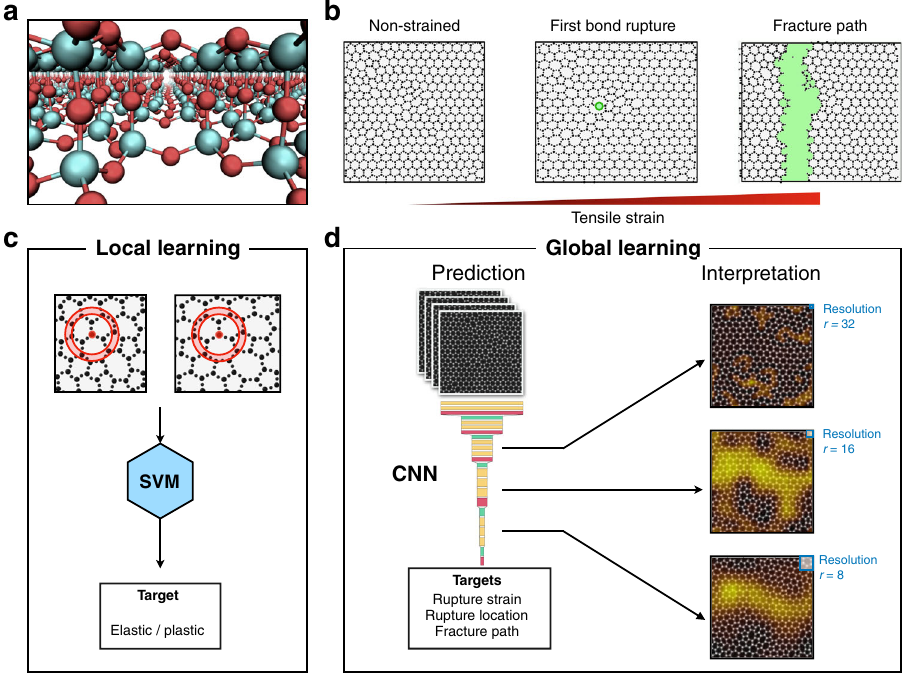
Fig. 1 Schematic of system and algorithms. a Perspective view of the silica glass bilayers: silica atoms are colored in cyan and oxygen ones in red. b Schematic representation of the fracture formation under increasing tensile strain from left to right: non-strained (left panel), fi rst plastic event corresponding to a bond breaking (central panel) and crack path (right panel). c Local learning approach that uses Support Vector Machine to predict the elastic/plastic nature of individual atoms. d Global learning approach which uses a ResNet model to predict rupture strain, location and the full crack path. The approach also allows for the interpretation of the model decisions using attention maps (right side of